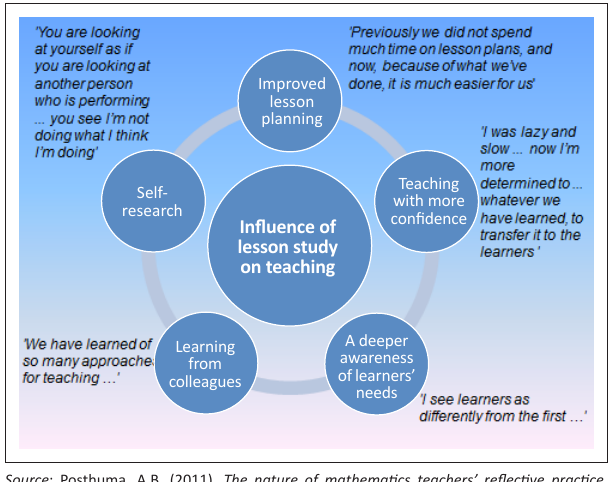
FIGURE 2: Influence of lesson study on teaching as reported by the